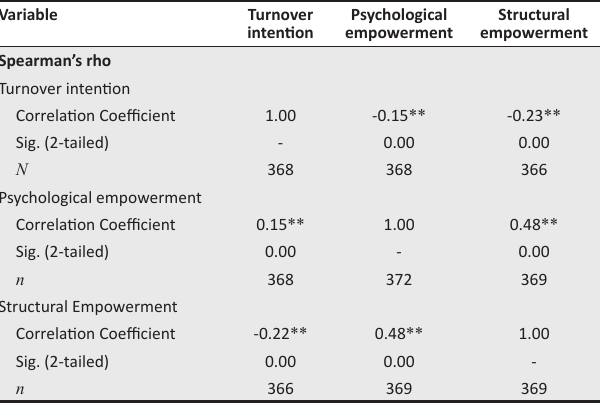
TABLE 4: Spearman’s rank correlation coefficient of structural empowerment, psychological empowerment and turnover intention.